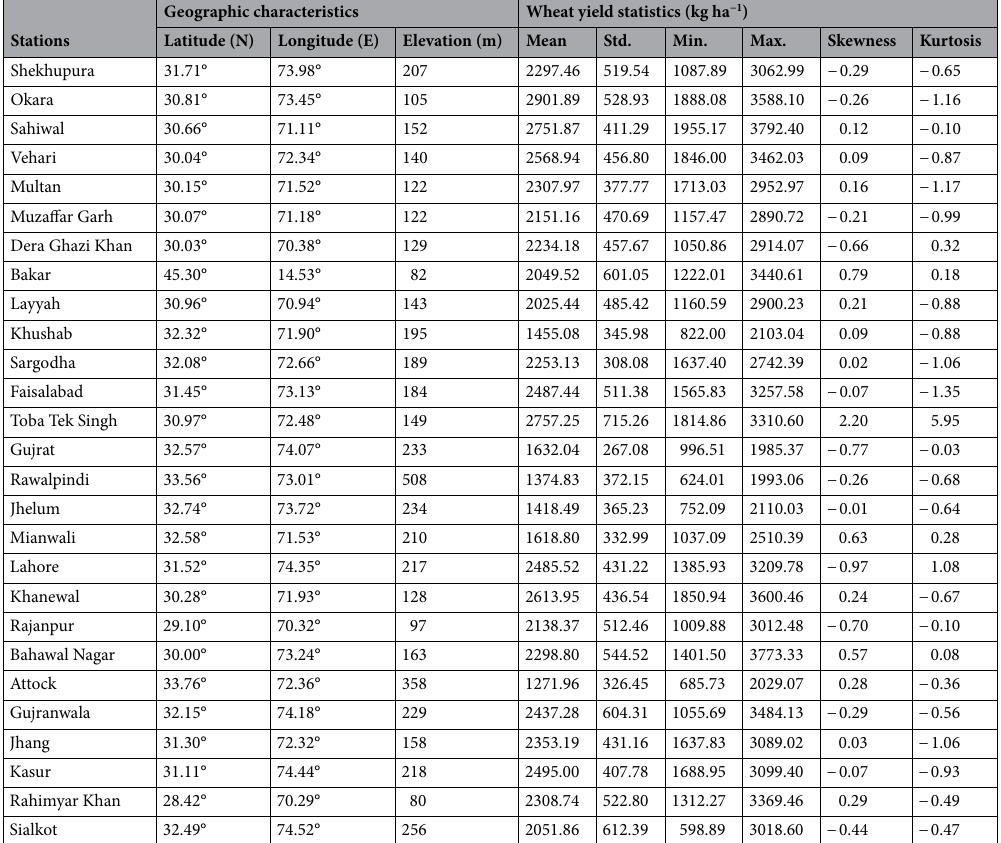
Table 1. Geographic properties and wheat yield statistics of the study stations for Punjab,